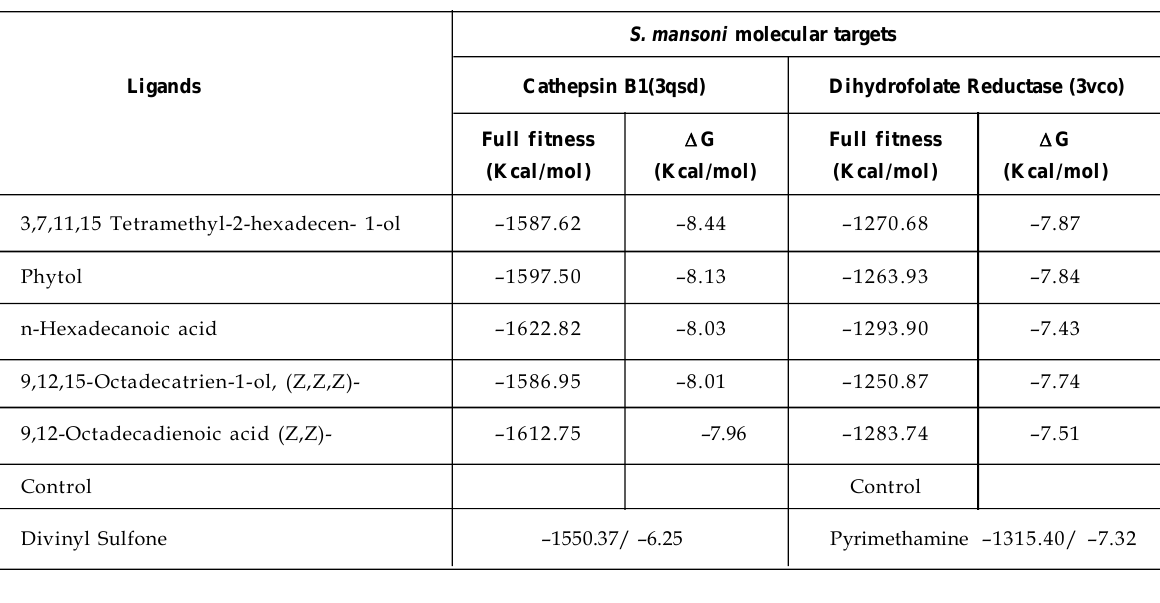
Table 4: Docking results of S. mansoni molecular drug